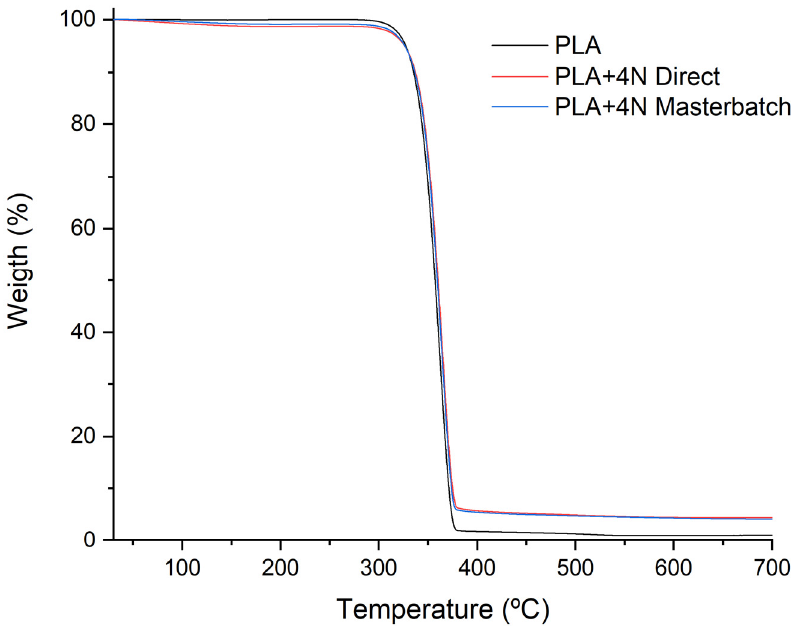
Figure 3. TGA termograph of PLA and PLA+4%N composites.